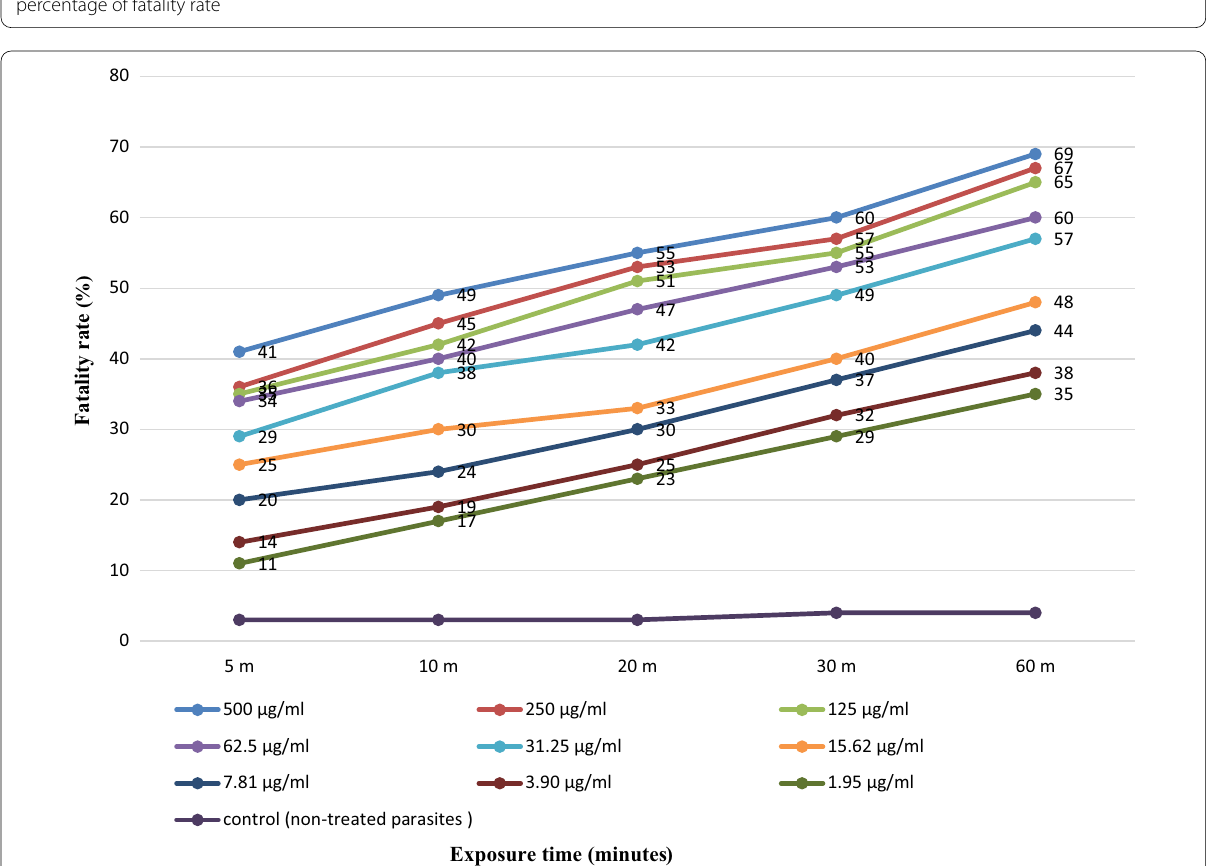
Fig. 5 Scolicidal effects of albendazole after exposure at different concentrations for 60 min. Each point represents the mean percentage of fatality